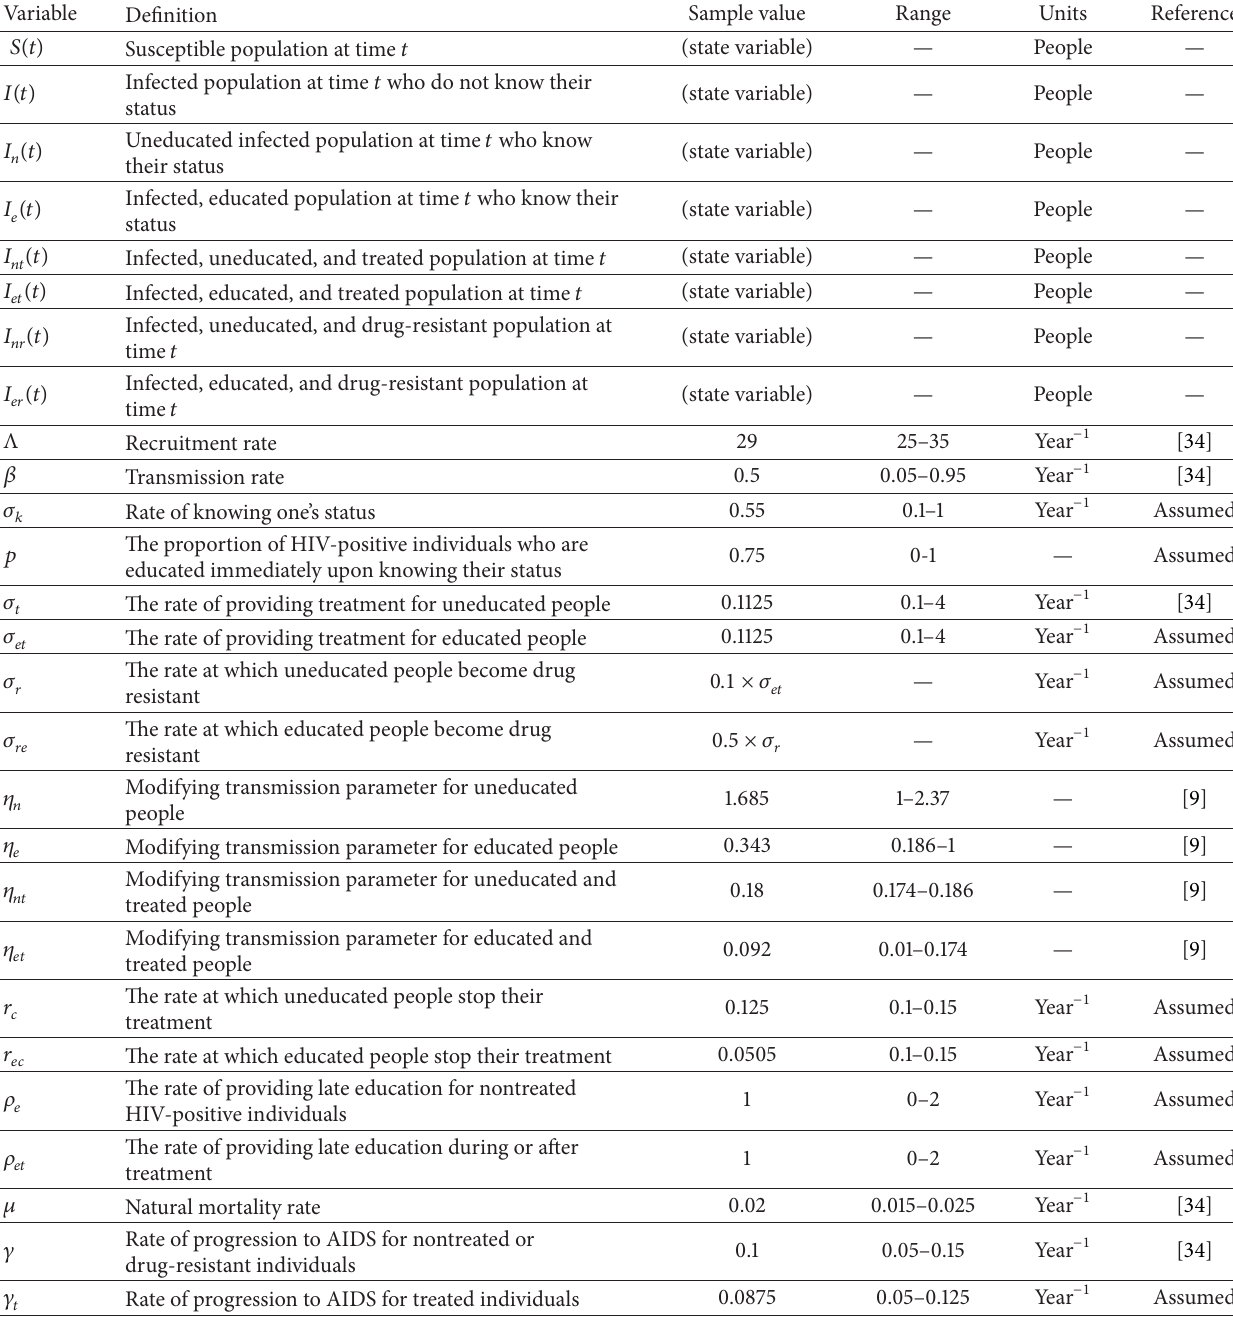
Table 1: Parameter